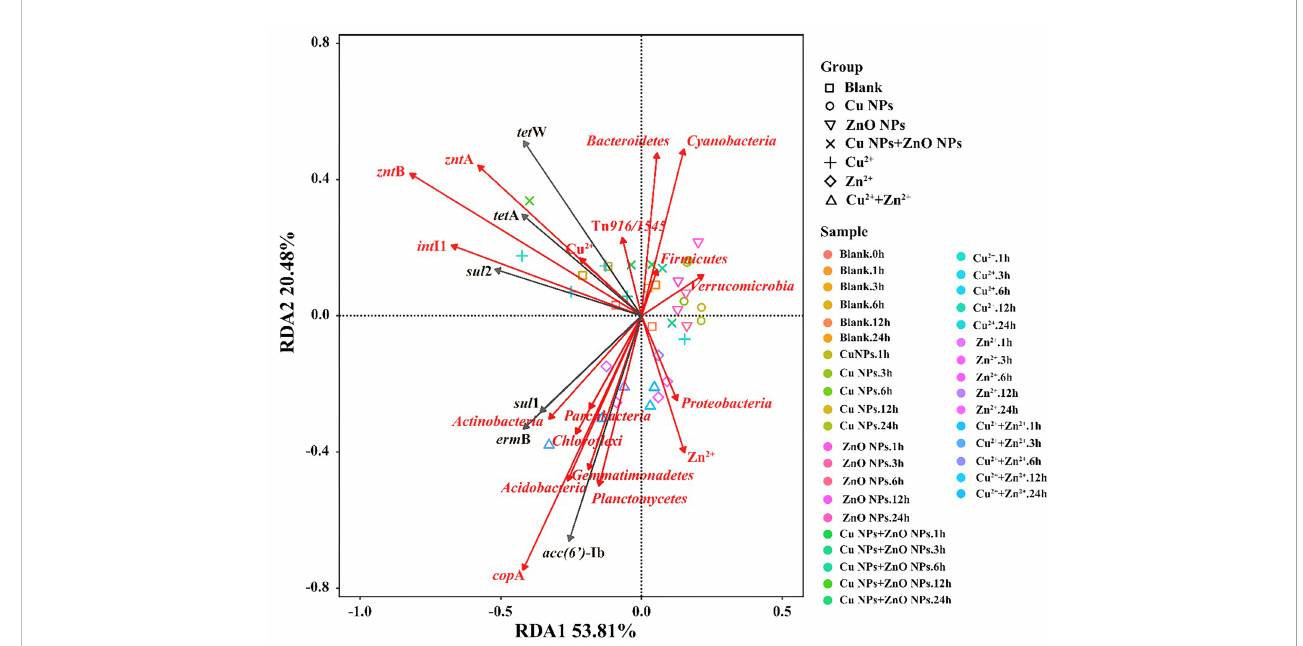
FIGURE 3 RDA analysis of microbial community (phylum), MGEs, MRGs, Cu 2+ , Zn 2+ and ARG abundances in all the